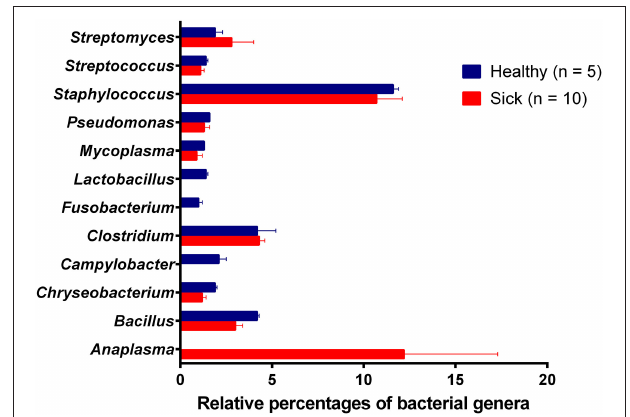
FIGURE 2 | Relative abundance (average percentage + standard error) of bacterial genera. No difference ( P -value = 0.54) in the diversity of bacterial genera between healthy (H = 2.28) and sick (H = 2.18) groups. Simpson’s evenness scores show uneven distribution of bacterial species in both apparently healthy (0.42) and sick (0.33) groups. TABLE 3 | Major bacterial species detected with equine blood metagenomic analysis. Bacterial